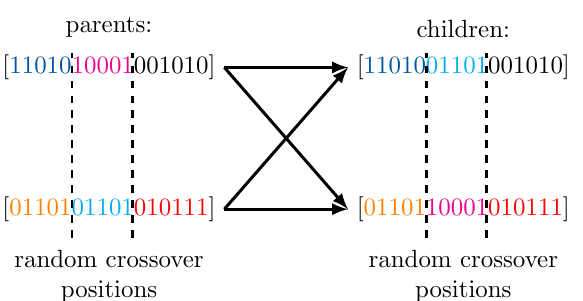
Figure 1. Illustration of a two point crossover in the processing of a genetic algorithm. The genotypes of the children are formed by combining the genotypes of both